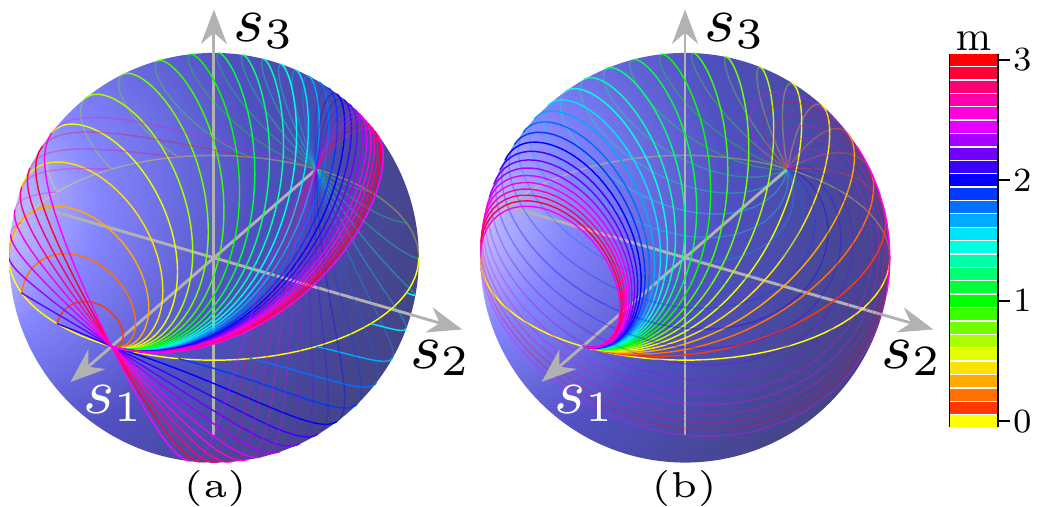
Figure 19. Family of Clélie curves, in the ( a ) direct form (Equation (91)), for the parameter ranging from m = 0 to 3, at steps of 1/9. Note that curves with different values of the parameter may pass by the same point, corresponding to different order solutions that have a different frequency behaviour. ( b ) The inverse form (Equation (95)), for the same parameter values of ( a ), in growing order from red to violet. The equator, in yellow, corresponds to m = 0, while in the previous figure it corresponds ∞ to m →